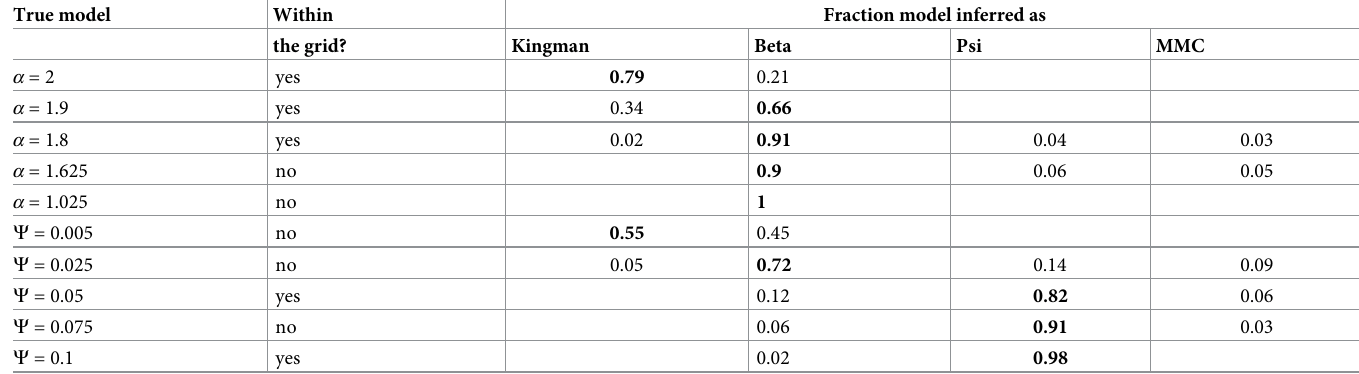
Table 1. Model selection via two-step Bayes factor criterion. Based on 2,000 simulations for each true model assuming n = 25 individuals with 100 loci with 50 mutations each on average. For each simulation, the coalescent parameter is fixed and the growth parameter g and the allele misorientation rate e are randomly chosen ( g 2 [0, 11.25], e 2 [0, 0.1]). The second column shows whether the parameters used for simulation were included in the inference grid. Fractions are rounded to two digits. The maximum of each row is marked in bold. MMC refers to cases in which neither the Psi- nor Beta-coalescent is preferred. An expanded version with enhanced sample size is provided in Table B in S1 Appendix. For details on simulations and inference parameters see A.7 in S1 Appendix.